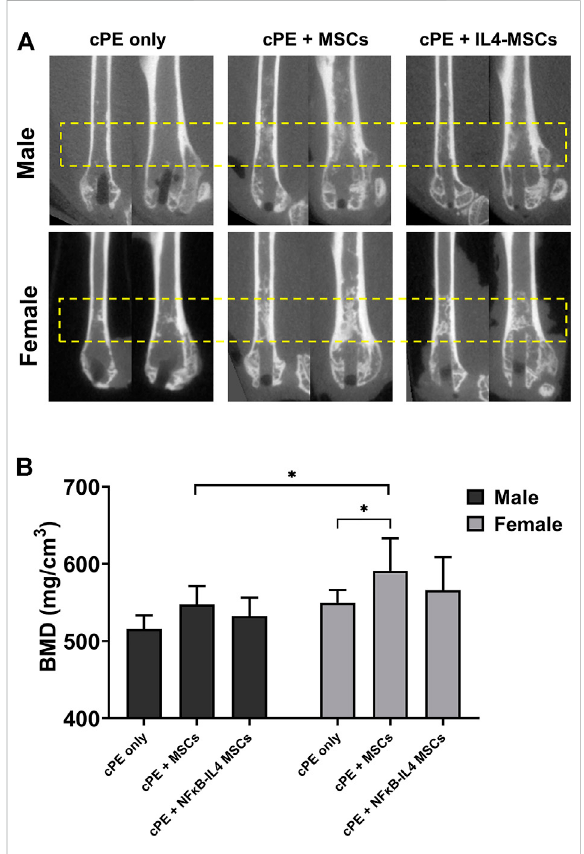
FIGURE 3 uCT examination and bone marrow density (BMD) values within the ROI for all groups at 6 weeks. (A) representative uCT images in sagittal and coronal planes. In both sexes, severe osteolysis appeared around the rod-shape hole in cPE only group, and it was mitigated after treatment of MSCs and NF κ B-IL4 MSCs, especially in female. (B) quantitative assessments of BMD within the ROI. In both sexes, MSC-based therapy enhanced the BMD. MSCs group in females was signi fi cantly increased compared to sex-matched cPE only control group. Females showed signi fi cant increase compared to males in MSCs groups (Males, cPE only group: n = 8, cPE + MSCs group: n = 9, cPE + NF κ B-IL4 MSCs group: n = 9; Females, cPE only group: n = 9; cPE +MSCsgroup: n =7,cPE+NF κ B-IL4MSCsgroup: n =6;* p < 0.05, Two-way ANOVA compared to sex-matched groups).